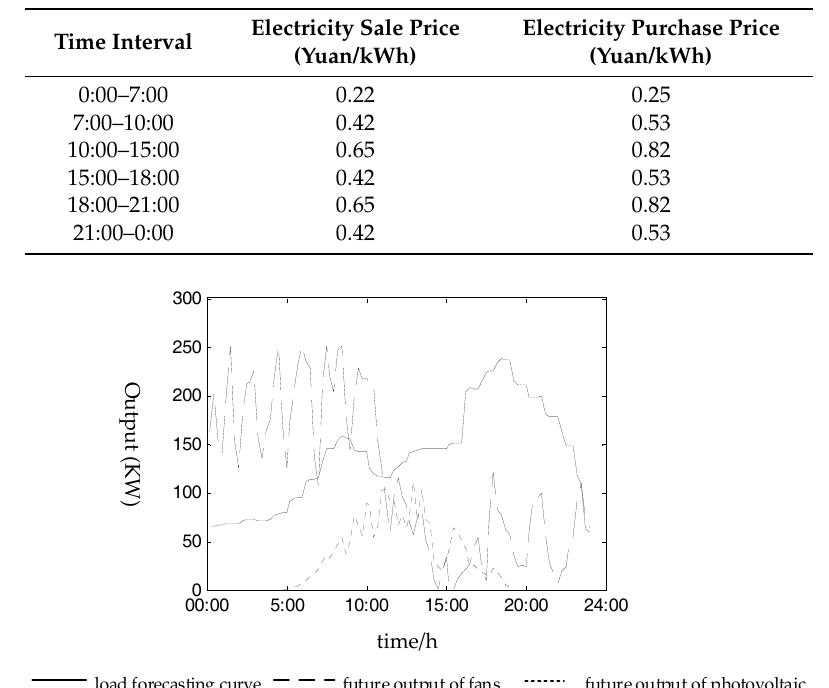
Figure 3. Forecast curve of load, wind power and PV output.